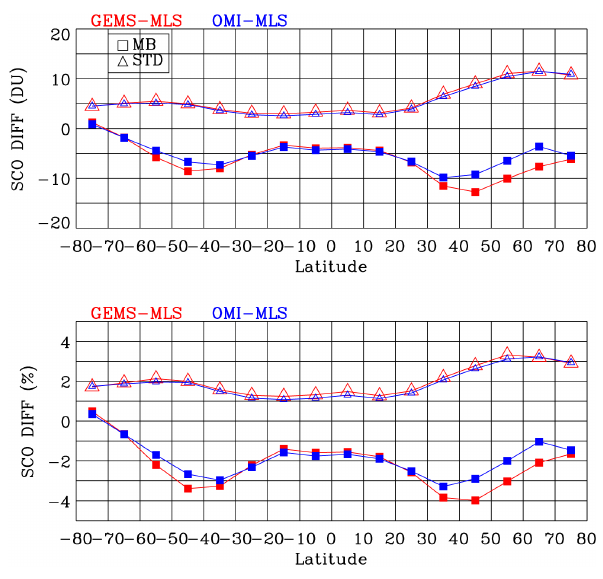
Fig. 6. Comparison of stratospheric column ozone (SCO) above 215hPa in 10 ◦ latitude bins for April 2006. The upper panel and lower panel display the mean biases (square symbol) and standard deviations (triangle symbol) for absolute differences (DU) and rela- tive differences (%), respectively. The relative difference is defined as the absolute difference × 100%/MLS.